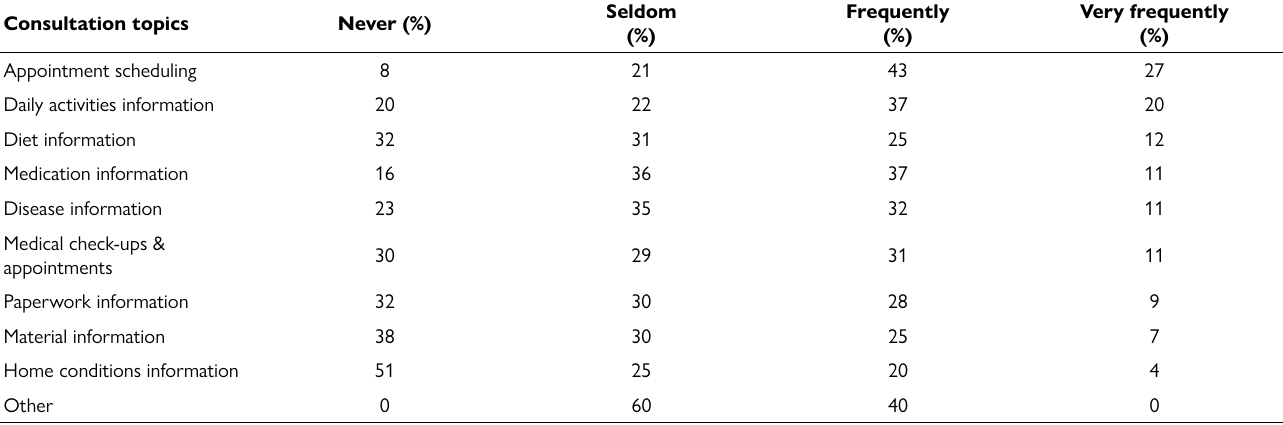
Table 7. Most frequent topics asked to